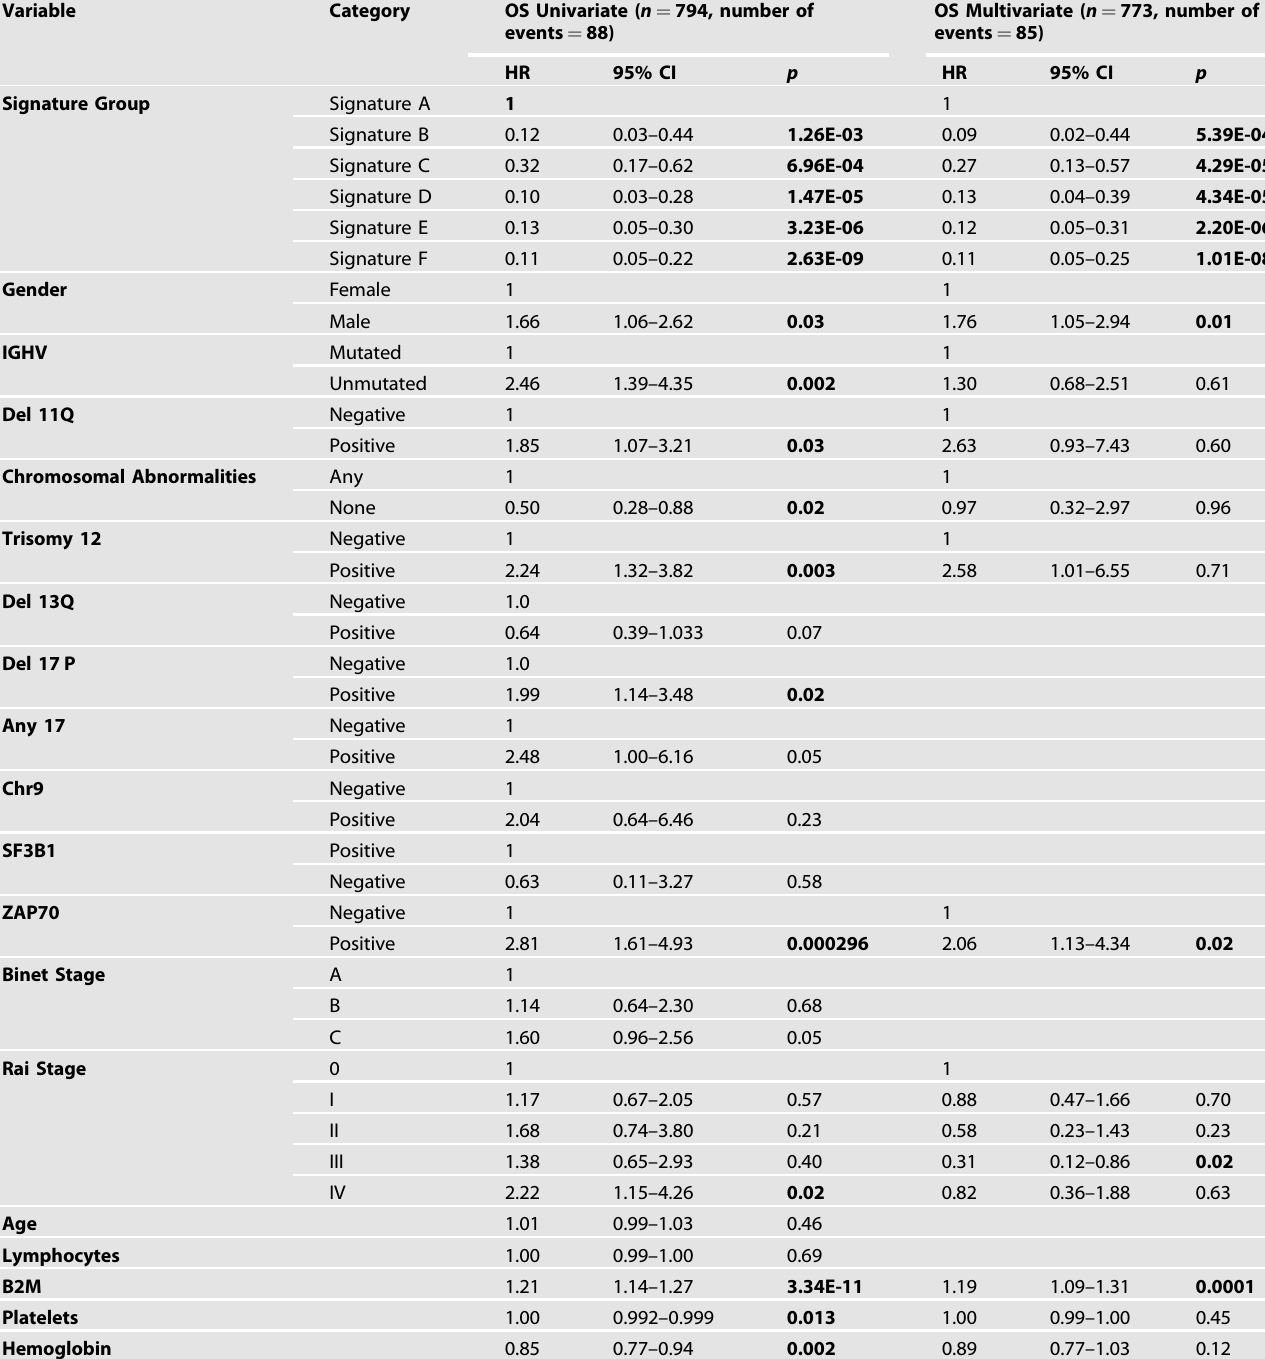
Table 2. Univariate and multivariate analysis of CLL prognostic factors for